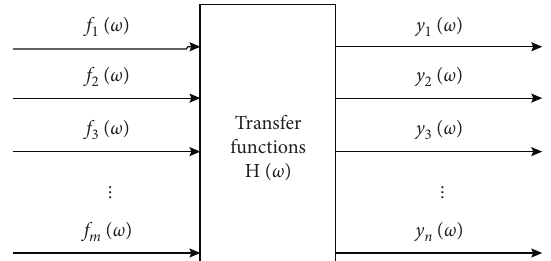
Figure 1: Multiple excitations and multiple responses model of linear time-invariant system in the frequency